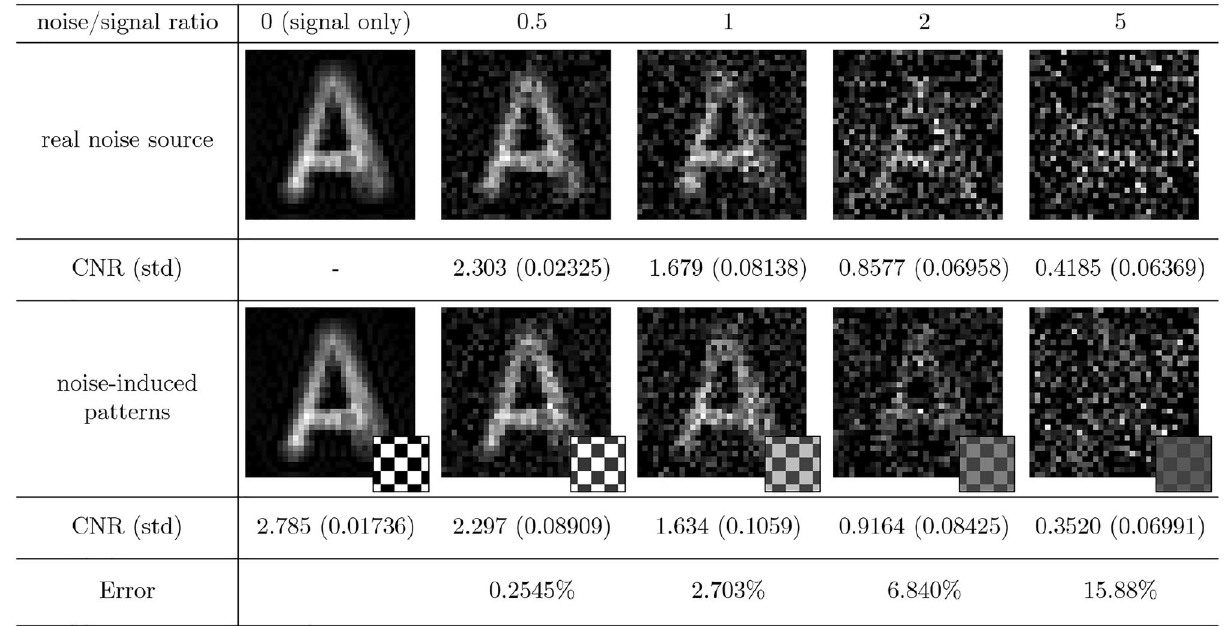
Figure 4. Alphabet A images obtained by using CGI with an external thermal noise source and those of CGI with noise-induced patterns. The small pictures show examples of the noise-induced patterns. We calculate contrast-to-noise ratio (CNR) and its standard deviation